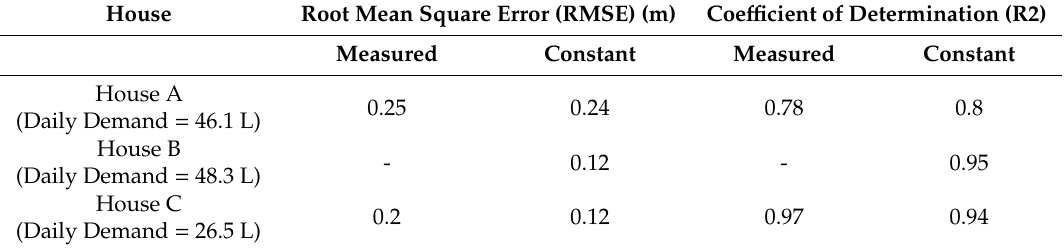
Figure 3. Validation of yield after spillage model: ( a ) House A, ( b ) House B and ( c ) House C. Table 2. Efficiency indexes for model validation.